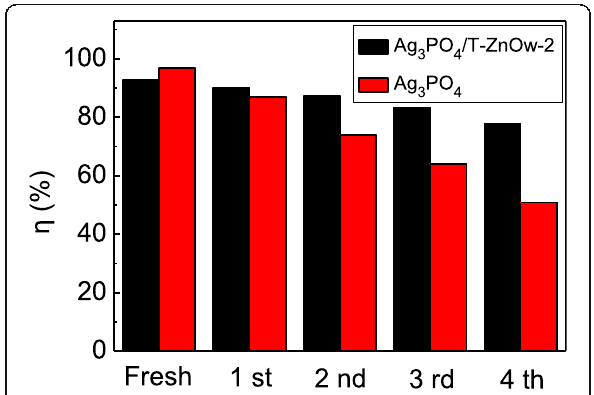
Fig. 7 Four successive cycling runs for degradation of RhB over Ag 3 PO 4 /T-ZnOw-2 and Ag 3 PO 4